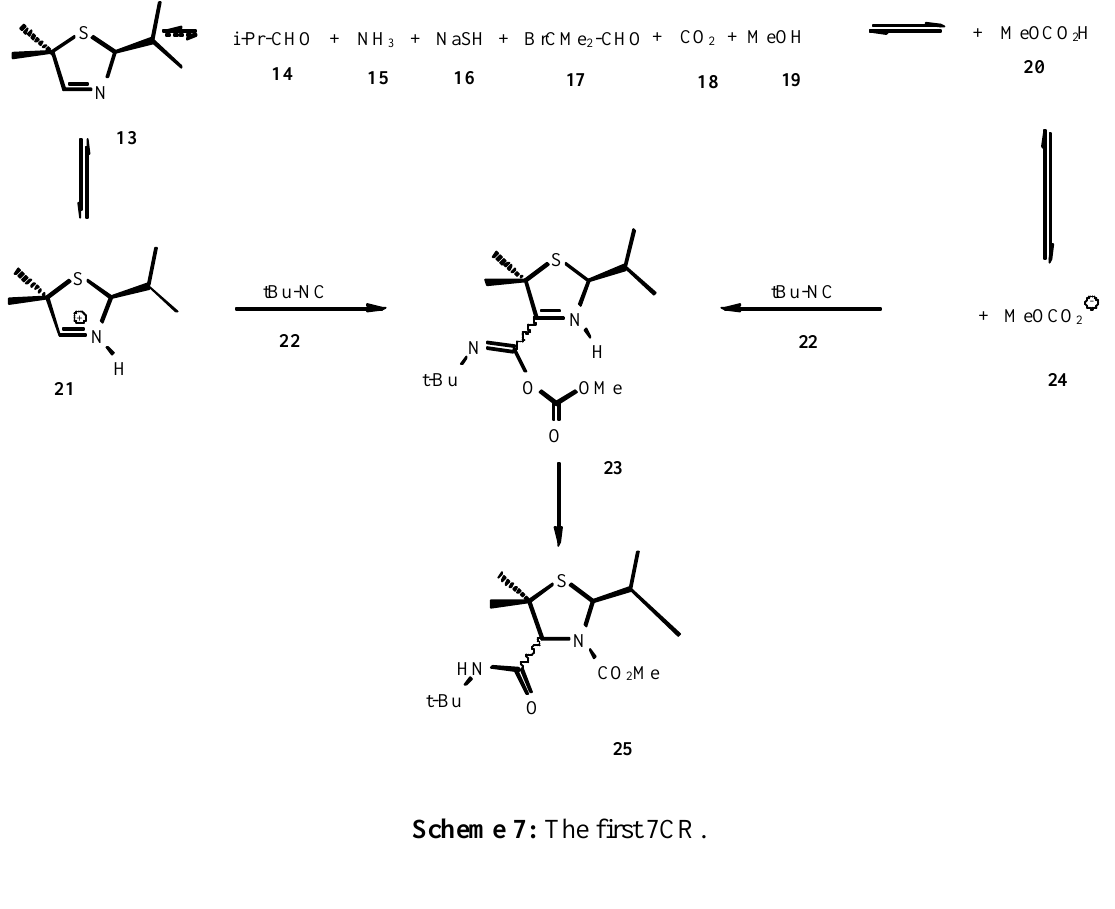
Scheme 7: The first